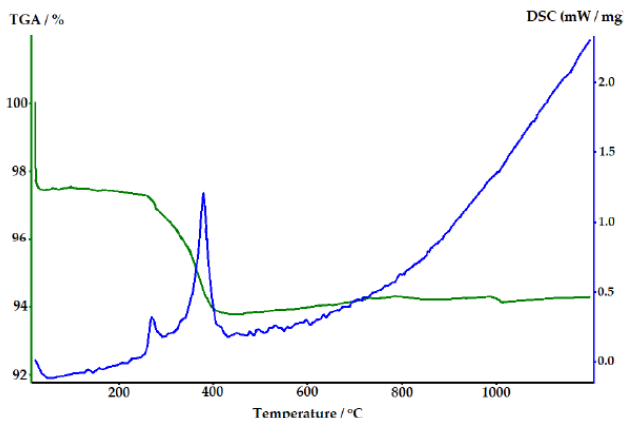
Figure 9. Results of thermogravimetric analysis and differential scanning